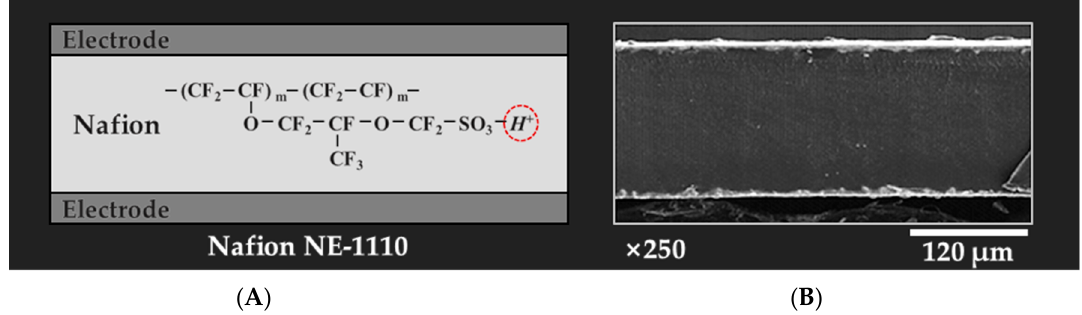
Figure 2. Nafion-based ionic polymer-metal composites: ( A ) structure of polymer electrolyte base layer and electrode; ( B ) scanning electron microscope image of a cross section.